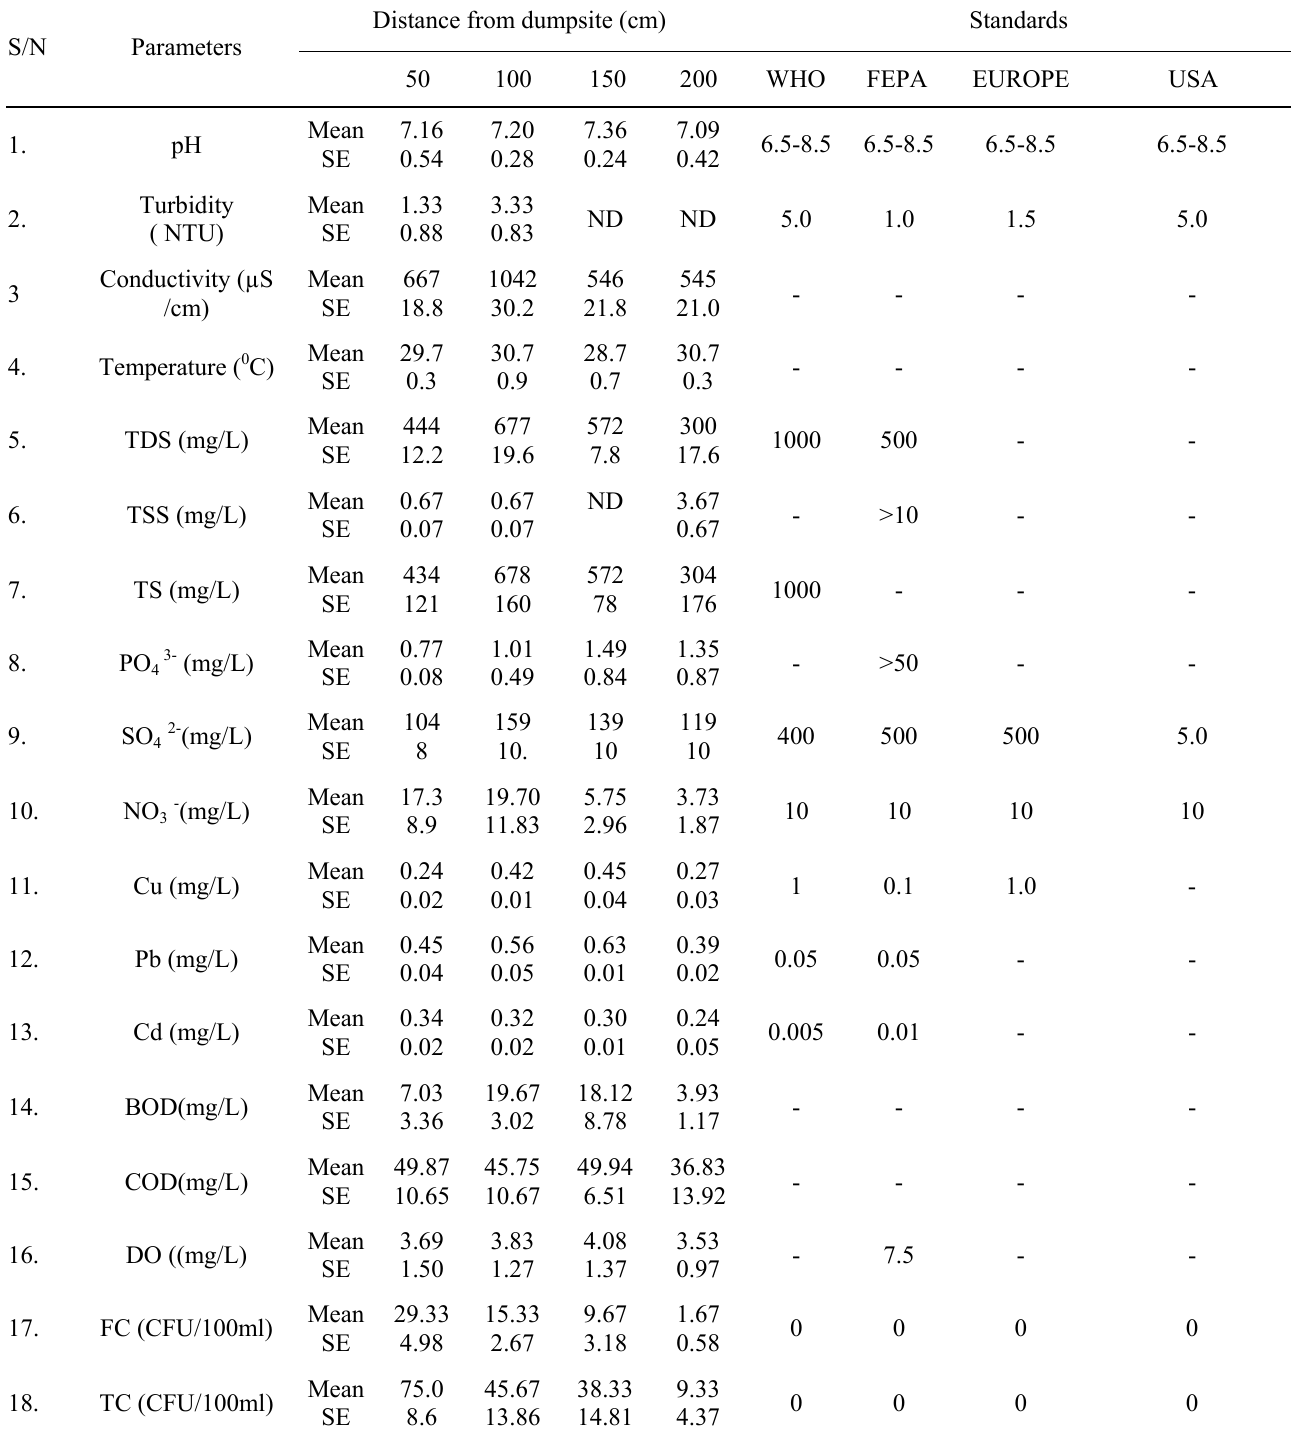
Table 2 : Mean values for the water quality parameters of wells located close to waste dumpsite in the wet season Distance from dumpsite S/N Parameters